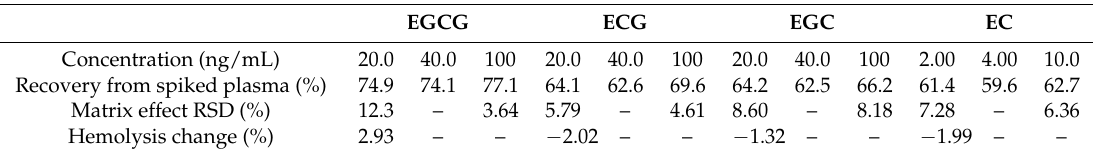
Table 3. Summary of the recovery, matrix effect, and hemolysis for the assay method (recovery and hemolysis, n = 3; matrix effect, n = 6). EGCG ECG EGC EC Concentration (ng/mL) 20.0 40.0 100 20.0 Recovery from spiked plasma